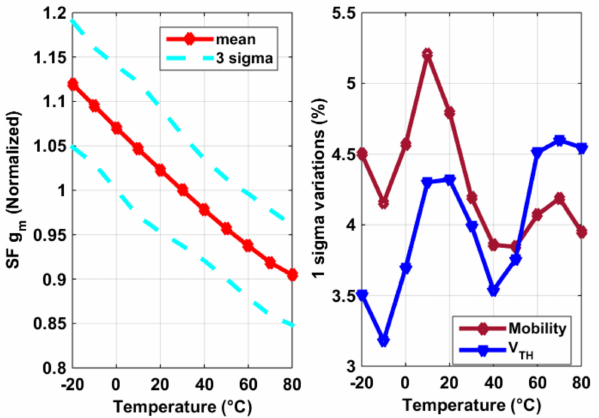
Figure 8. Measurement results of the SF g m,SF ’s temperature dependency ( left ) and the process variability of threshold voltage V TH and µ n CoxW/L ( right ) in Figure 7, using constant current bias.